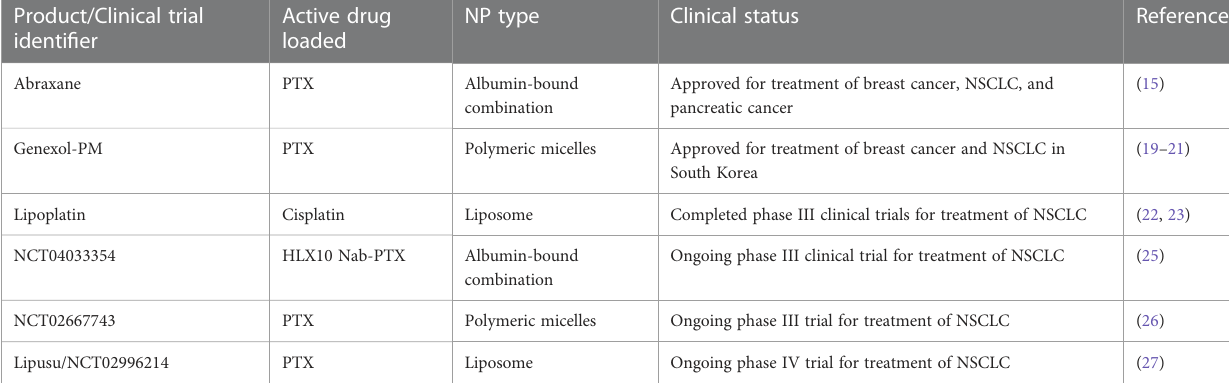
TABLE 1 Nanoformulations approved or in phase III/IV clinical trials for the treatment of NSCLC. Adapted from Holder et al. (24).